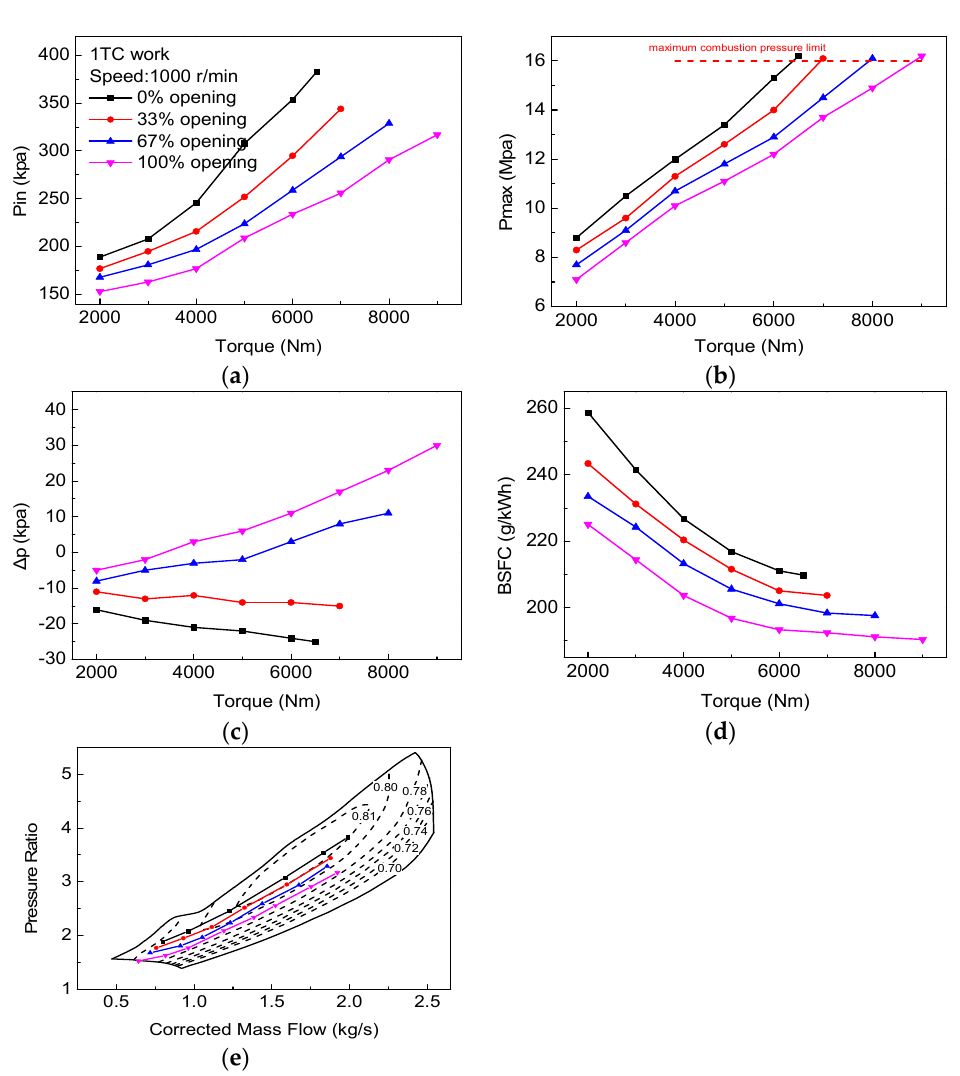
Figure 5. Variations of the main engine parameters at 1000 r/min with the 1TC. ( a ) intake pressure. ( b ) the maximum combustion pressure. ( c ) difference between the intake and exhaust pressures. ( d ) brake specific fuel consumption. ( e ) compressor.